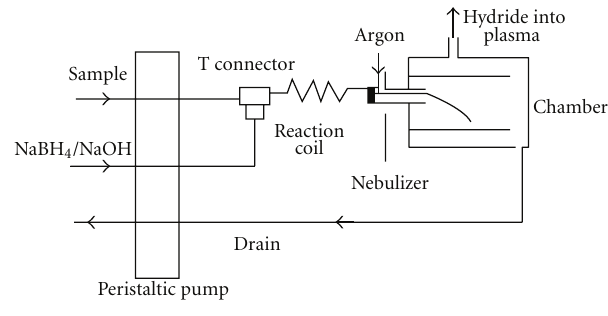
Figure 1: Hydride generator (HG) schematic.